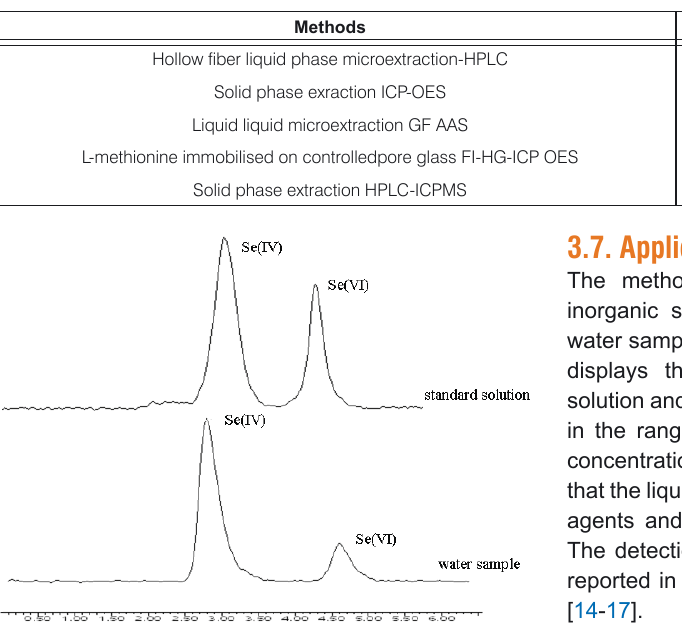
Table 3. Comparisons of the detection limits for inorganic selenium